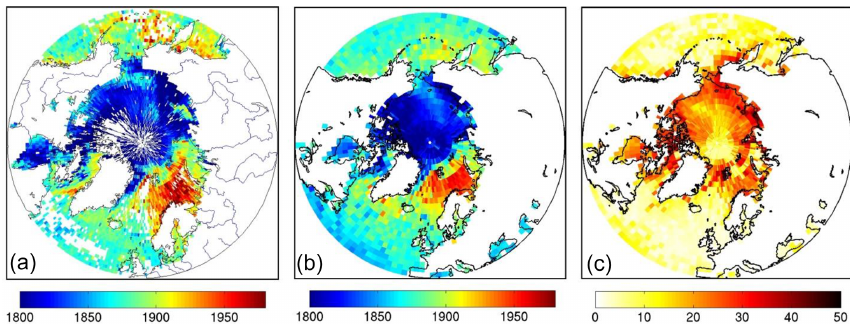
Figure 4. (a) IASI XCH 4 (0–4km) retrievals (ppb) for 2 March 2013 (sea only). (b) Contiguous IASI maps for the Northern Hemisphere for the same day obtained using spatio-temporal moving window block kriging at 2 . 5 × 2 ◦ spatial resolution and (c) associated uncertainties, given as 1 σ ( σ ˆ z )